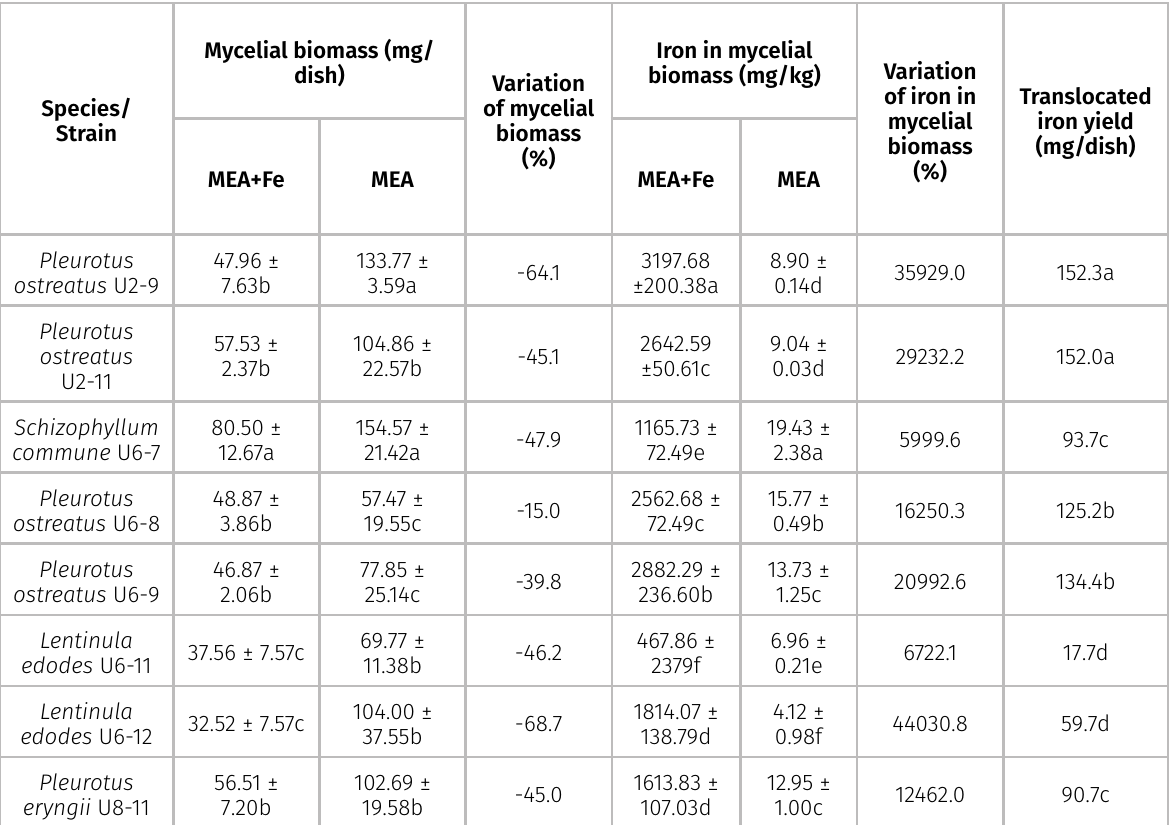
Table I. Translocated iron per Petri dish yield, iron in mycelial biomass, and mycelial biomass (dry basis) grown in malt extract agar with and without addition of 50.0 mg/L